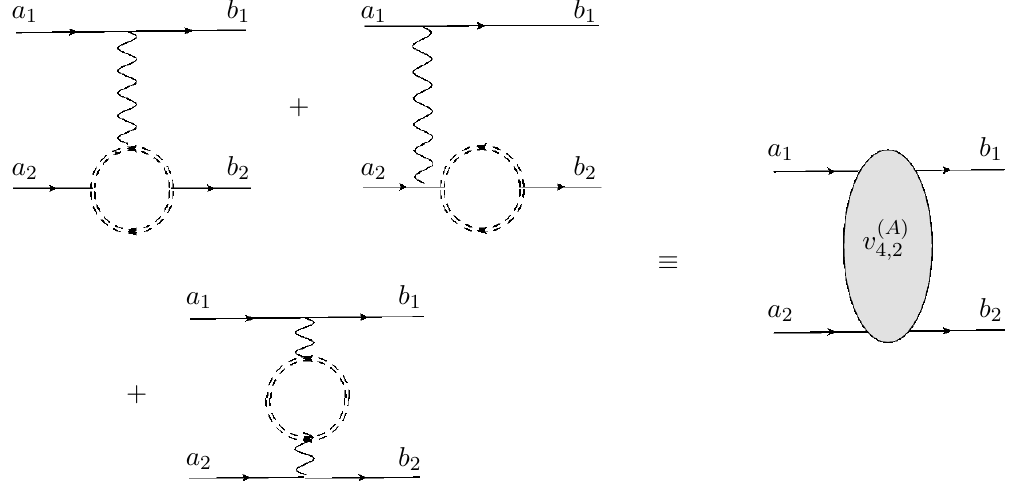
contribution. 4 ; 2